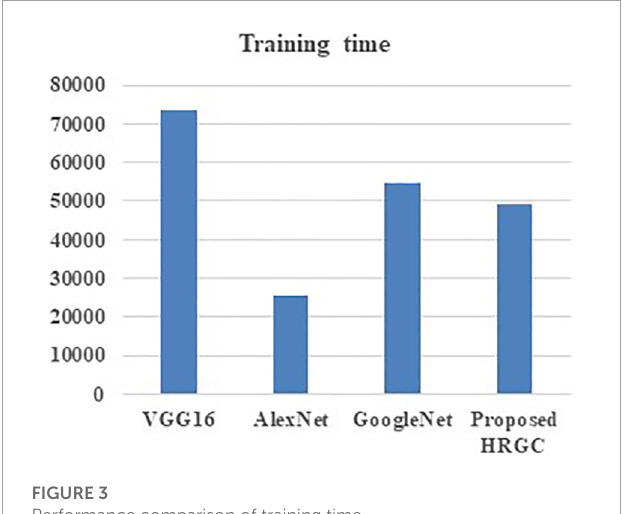
FIGURE 3 Performance comparison of training time.